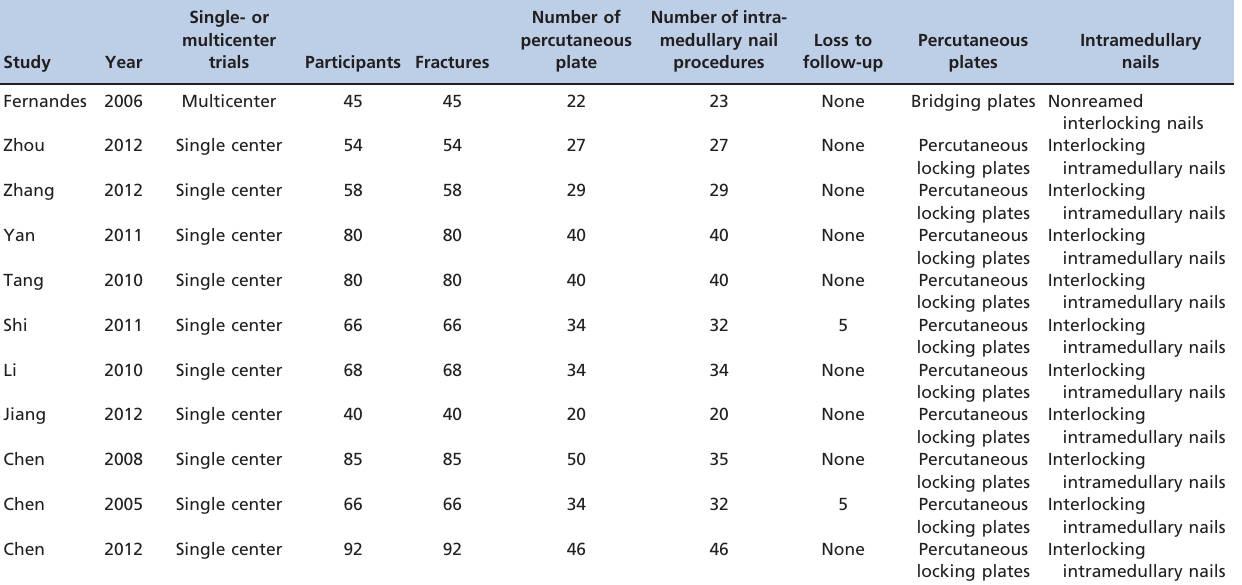
Table 2 - Characteristics of the included studies.